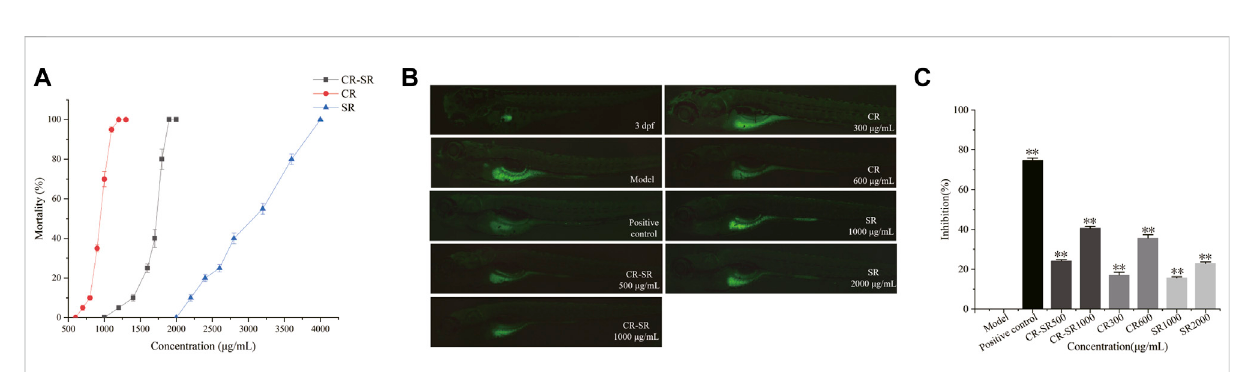
FIGURE 11 Activityofanti-livercancerinthezebra fi shHepG2xenograftmodel. (A) Dose – toxicitycurvesin3 – 6dpfzebra fi sh. (B) EffectsofCR-SR,CR,and SR on the tumor area in zebra fi sh (×40). (C) Inhibition rates of the CR-SR, CR, and SR groups. ** p < 0.01 compared with the model